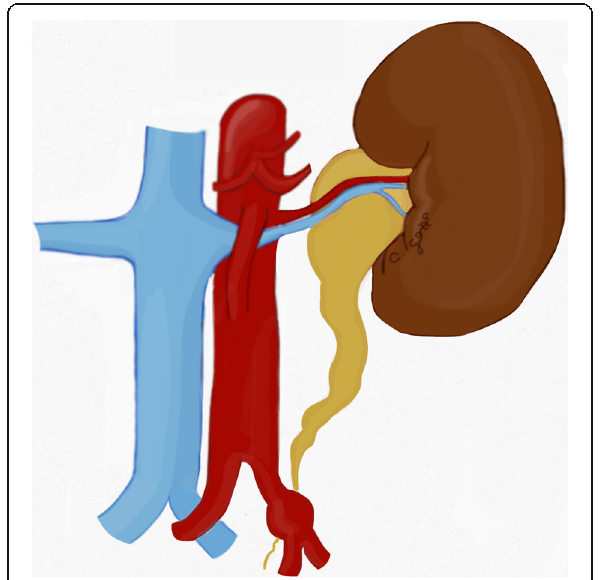
Fig. 14 Drawing illustrating the coronal view of ureteral obstruction by common iliac artery aneurysm